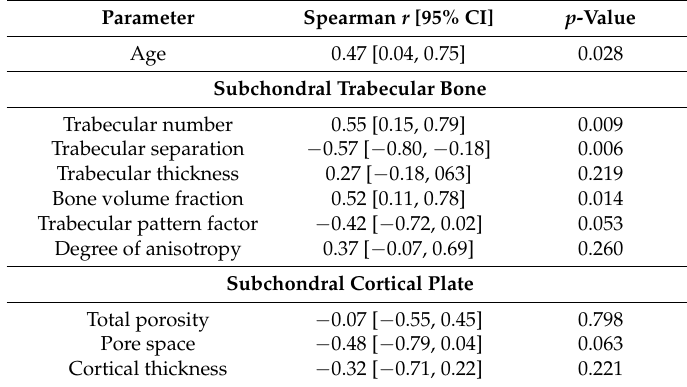
Table 2. Correlation between Weishaupt grade and bone structural parameters in FJOA.